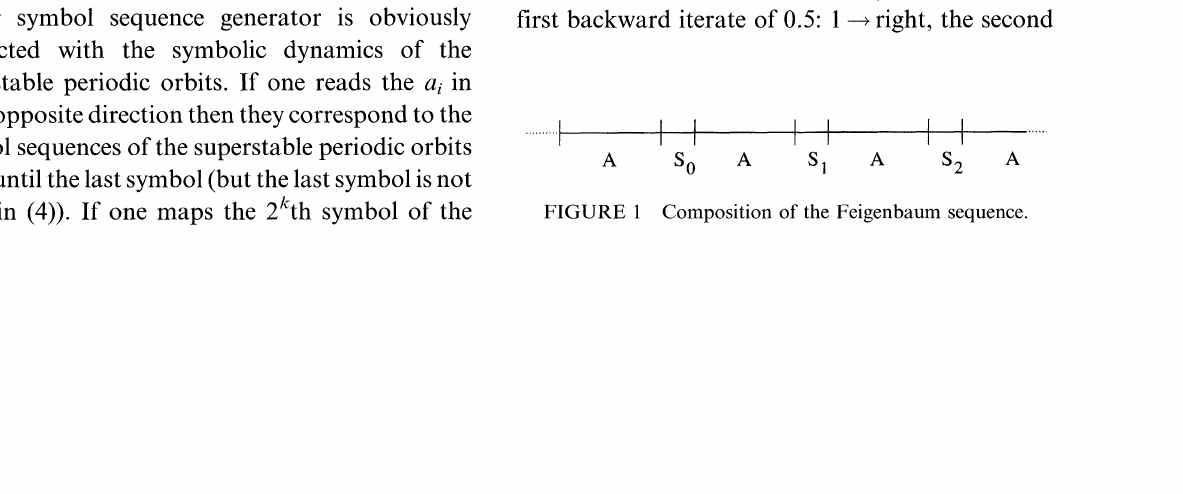
FIGURE Composition of the Feigenbaum